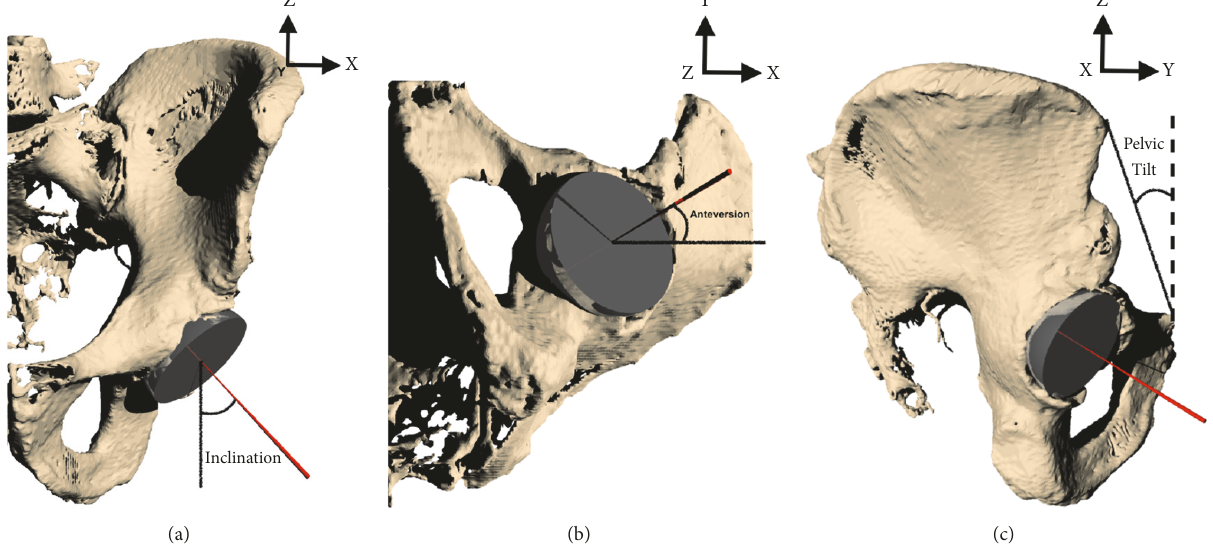
Figure 1: Transformations of vector normal to cup flat surface (red line) starting with (a) inclination, then (b) anteversion, and finally (c) pelvic tilt (dotted line is starting orientation and solid line is rotated orientation, with positive tilt being posterior pelvic